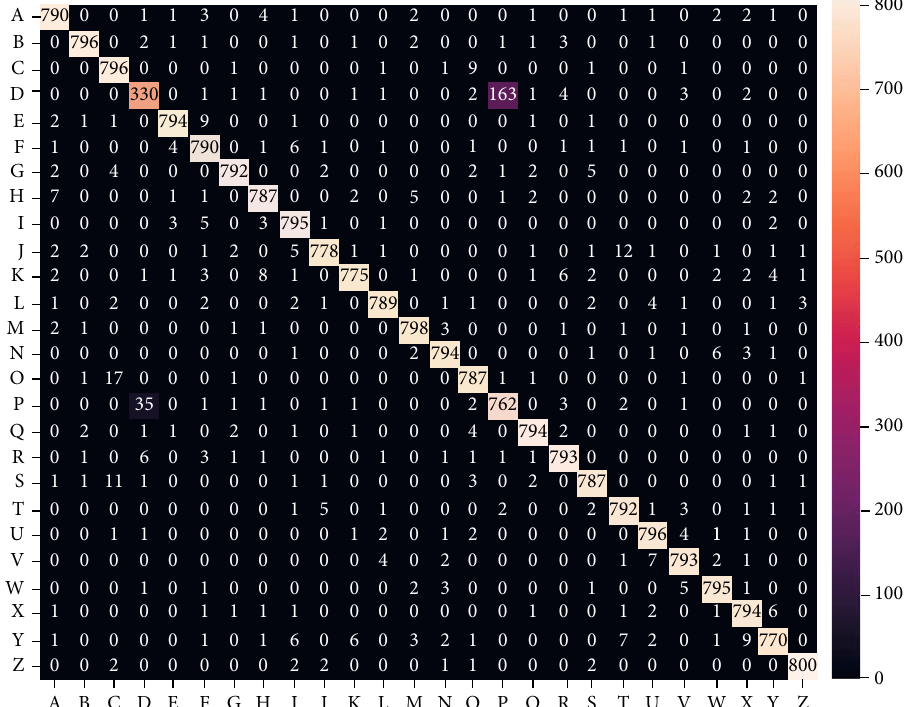
Figure 8: Confusion matrix for the smart-band dataset for the proposed CNN-LSTM